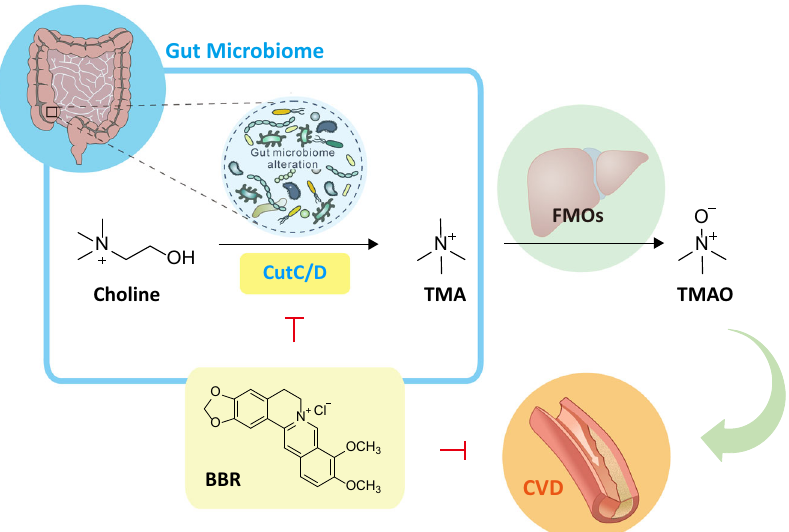
Fig. 7 The role of BBR in the regulation of TMAO production and the treatment of CVD. BBR inhibits commensal microbial TMAO production via gut microbiota alteration. Black arrows indicate choline-TMA-TMAO transformation, green arrow represents promotion, and blocked line in red indicates